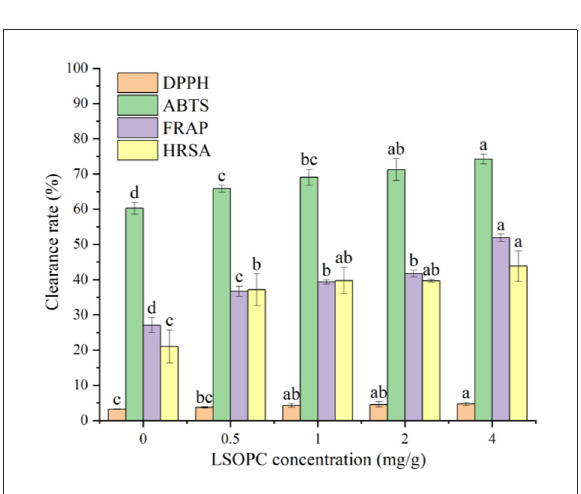
FIGURE4 Effect of LSOPC on DPPH, ABTs, HRSA, FRAP scavenging activity. Significant differences (p < 0.05 ) of data values were indicated by different